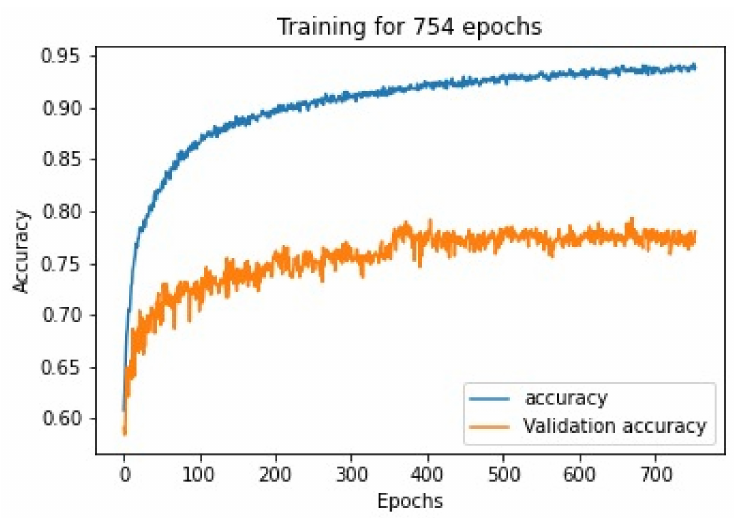
Figure 8. Accuracy v/s epoch graph for Siamese network model trained after training for 754 epochs.